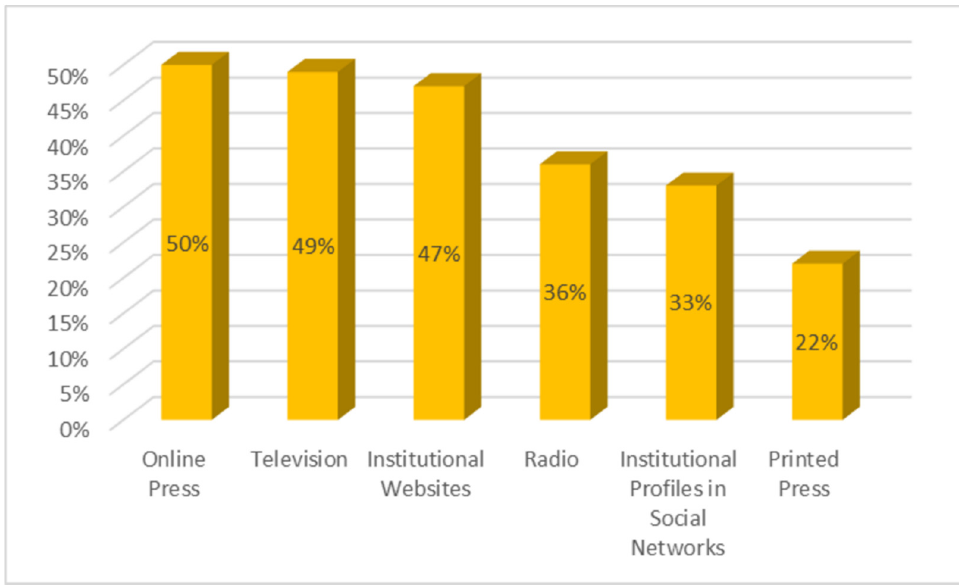
Figure 2. Sources that generate greater credibility for information on the COVID-19.